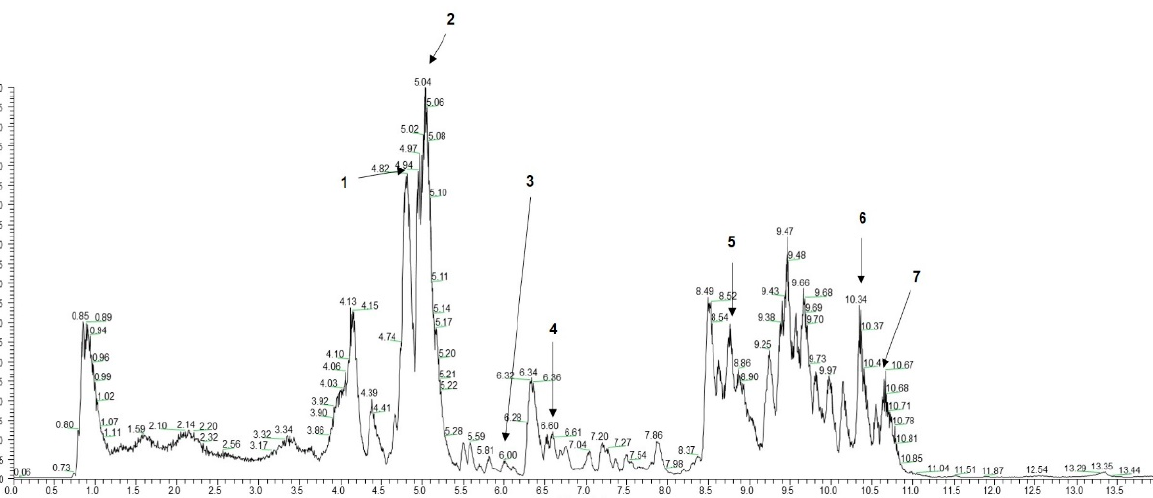
Figure 1. HPLC chromatogram of AME. (1) Rutin (Rt, 4.79), (2) Kaempferol-3-O-rutinoside (Rt, 5.04), (3) Quercetin (Rt, 6.03), (4) Kaempferol (Rt, 6.55), (5) Muricoreacin (Rt, 8.74), (6) Annonacin (Rt, 10.39) (7) Annonacinone (Rt, 10.59).